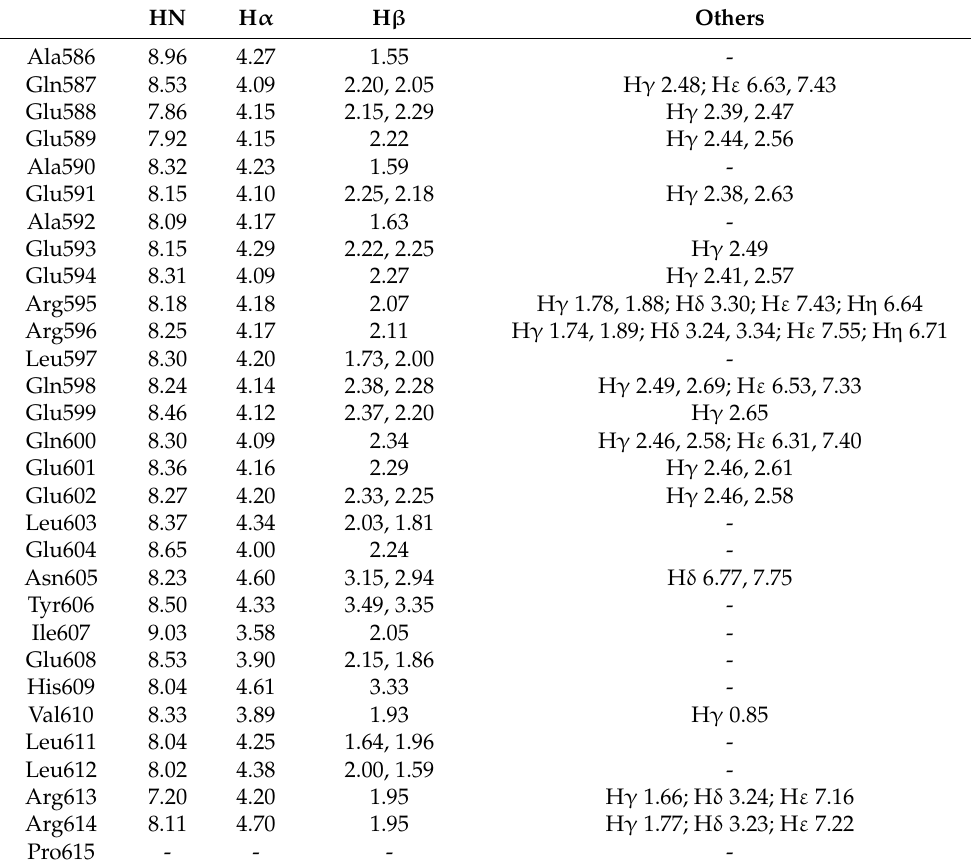
Table 1. AQEE-30 chemical shifts of the assigned 1H resonances in the HFIP solution.